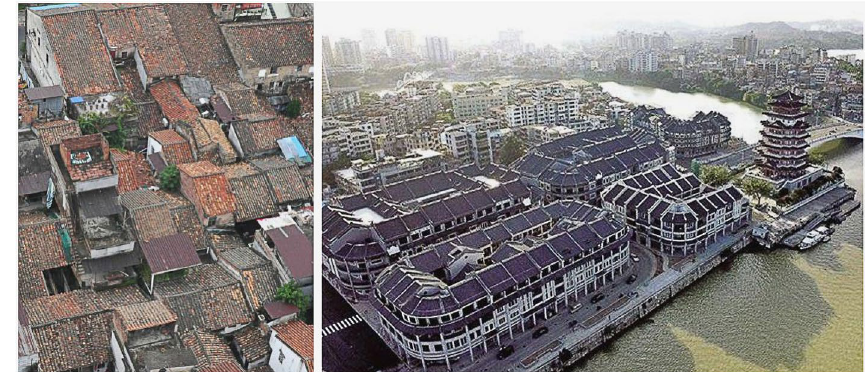
Fig. 6 Urban fabric of the Quarter (left) versus the reconstructed West Shuidong Street (right). (Source: An-Design